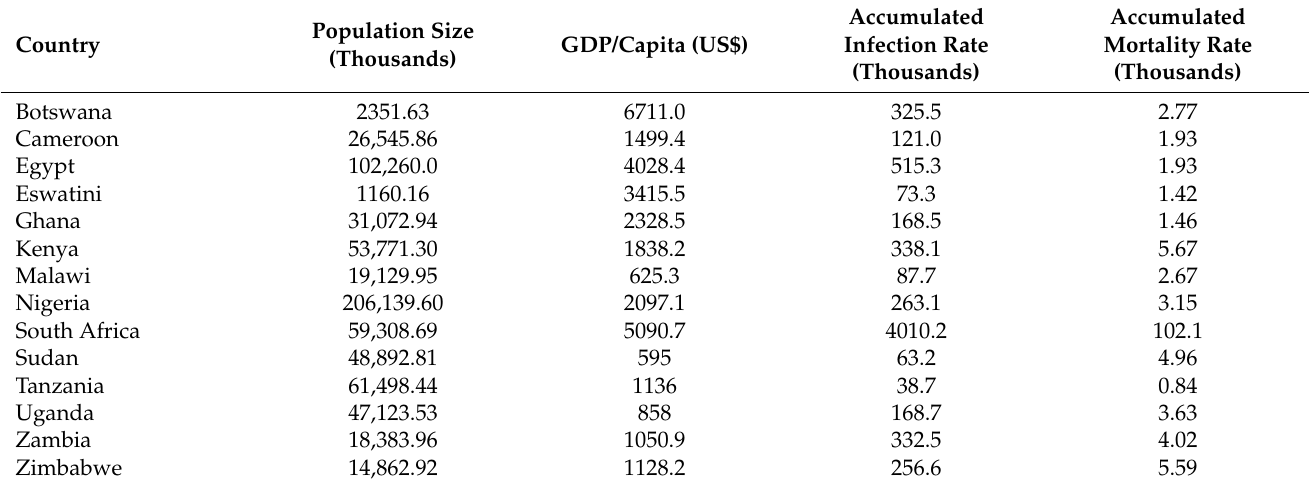
Table 1. Current population size, GDP/capita, and COVID-19 infection rates among participating African